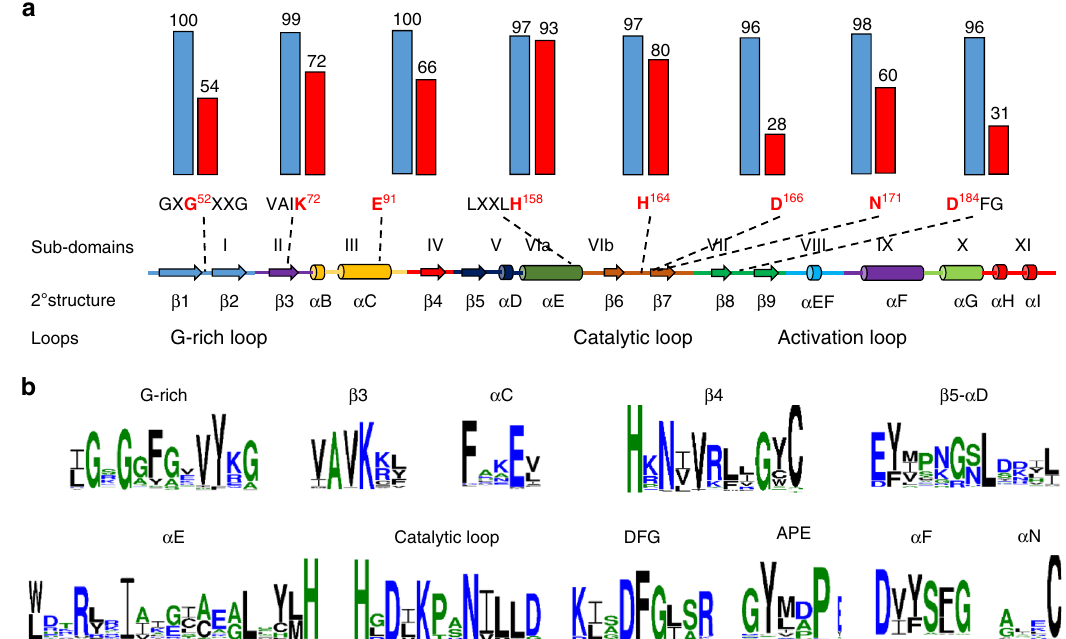
Fig. 4 Predicted structures of putative kinase and pseudokinase domains of TKP proteins based on 92 proteins from ten plant species. a Conservation of key motifs, residues, and secondary structure between putative kinase and pseudokinase domains. The secondary structure of a canonical kinase is shown with the standard annotations of its subdomains 27 . Eight key residues are marked in red, with numbers that are based on their positions in α cAMP- dependent protein kinase catalytic subunit (cAPK) 27 . Dashed lines indicate positions within secondary structure elements. The histograms above the motifs represent the degree of conservation (% of identical to conserved residuals) for putative kinase (blue columns) and putative pseudokinase (red) domains. b Sequence logos representing the conservation of key motifs and neighboring sequences in putative kinase domains. The size of the letters corresponds to their information